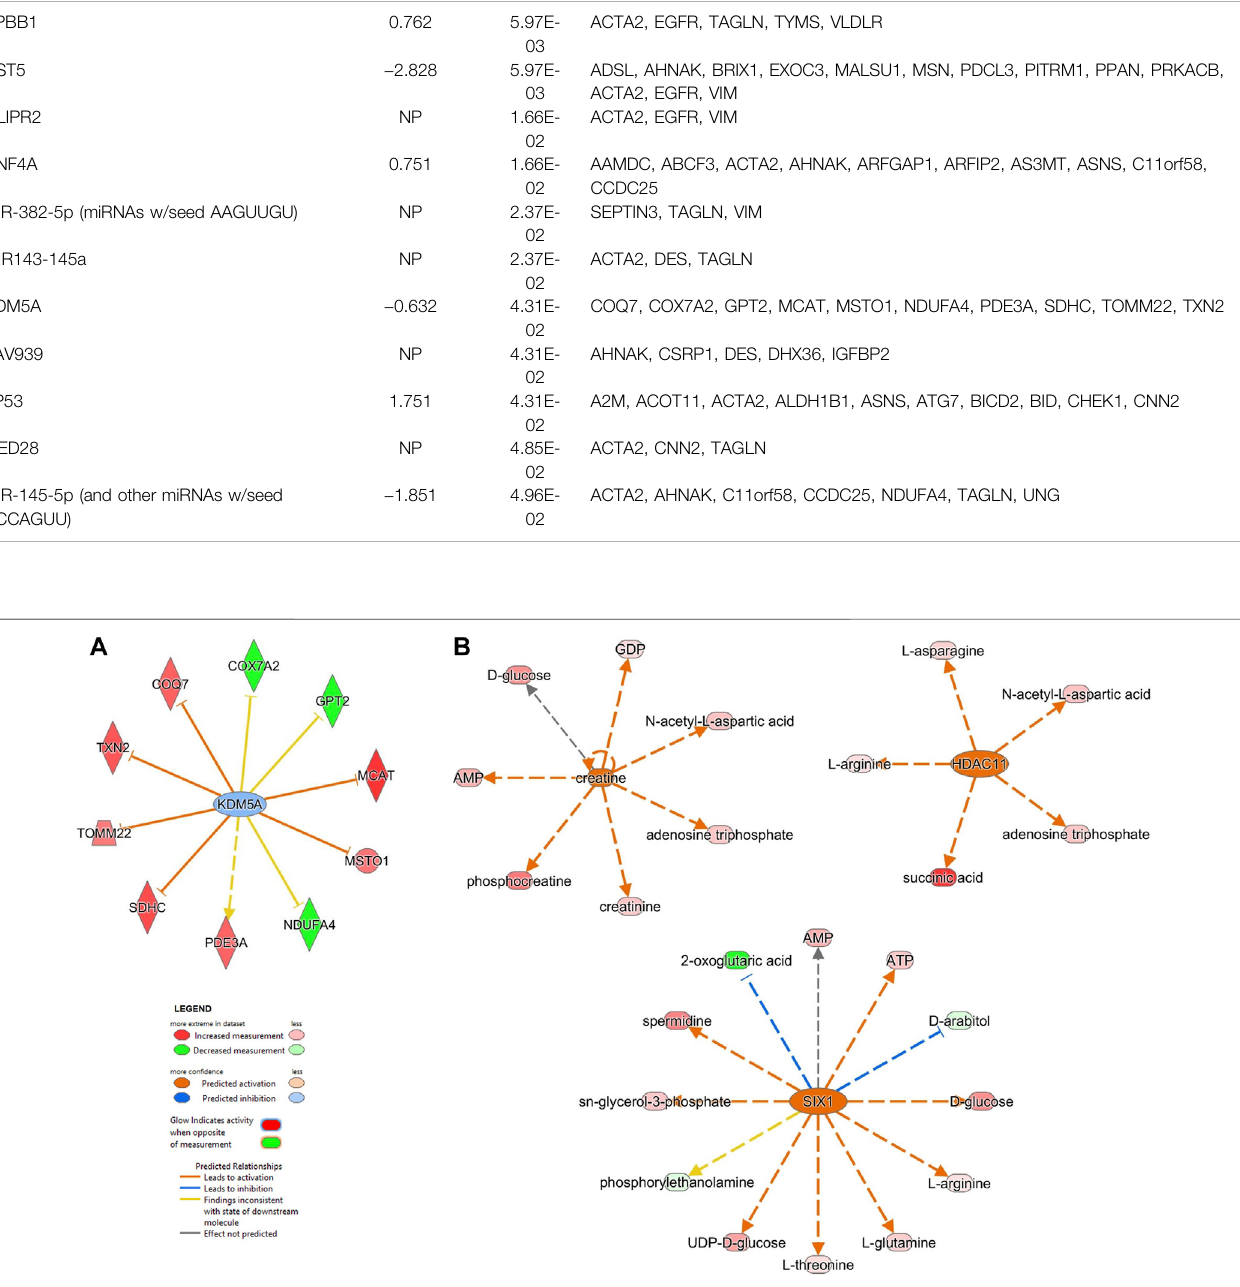
FIGURE 5 | Upstream analysis using proteomics and metabolomics datasets showed potential up-regulators mediating the effects of the enzymatic depletion of mitochondrial polyP in SH-SY5Y MitoPPX cells. (A) The proteomics analysis showed that KDM5A (lysine-speci fi c demethylase 5A) is one of the fi rst 10 upstream regulators, which is predicted to regulate different mitochondrial proteins such as COX7A2 subunit of complex IV and NDUFA4 subunit of complex I. (B) The metabolomics analysis identi fi ed creatine, SIX1 (homeobox protein SIX1) and HDAC 11 (histone deacetylate 11) as upstream molecules predicted to regulate different mitochondrial metabolites such as ATP, AMP, phosphocreatine, succinic acid and 2-oxoglutaric acid. This fi gure was prepared using IPA predictions from the same samples used for the metabolomics and proteomics assays ( fi ve replicates, collected on two independent days).